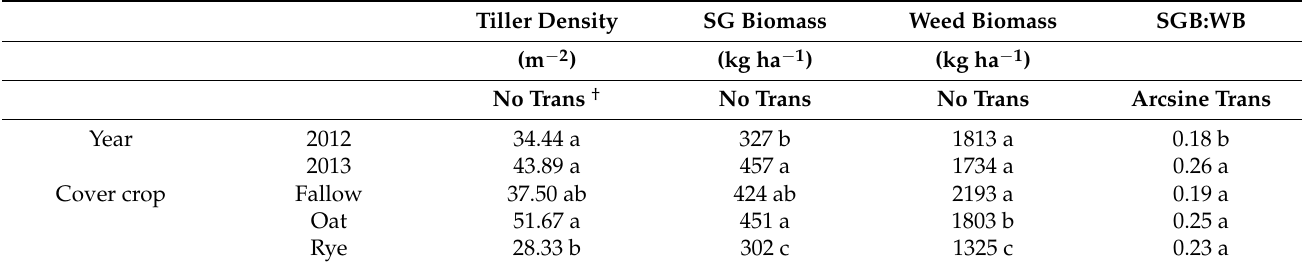
Different letters next to the treatment means indicate significant differences ( p < 0.05). † Trans indicates that the data were